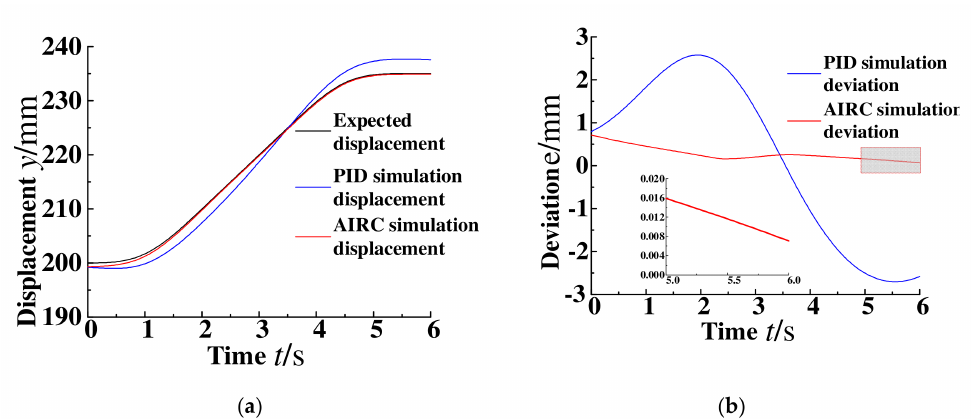
Figure 9. System displacement and deviation curve under working condition 4 (cid:13) . ( a ) System displace- ment curve. ( b ) System displacement deviation curve.